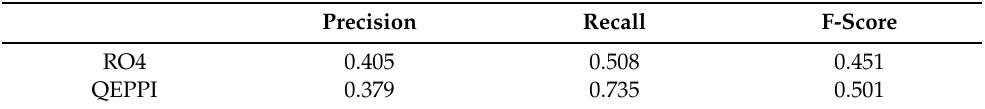
Table 3. Precision, Recall, and F-score values for one violation of RO4 and QEPPI scores with a threshold value of 0.5196.